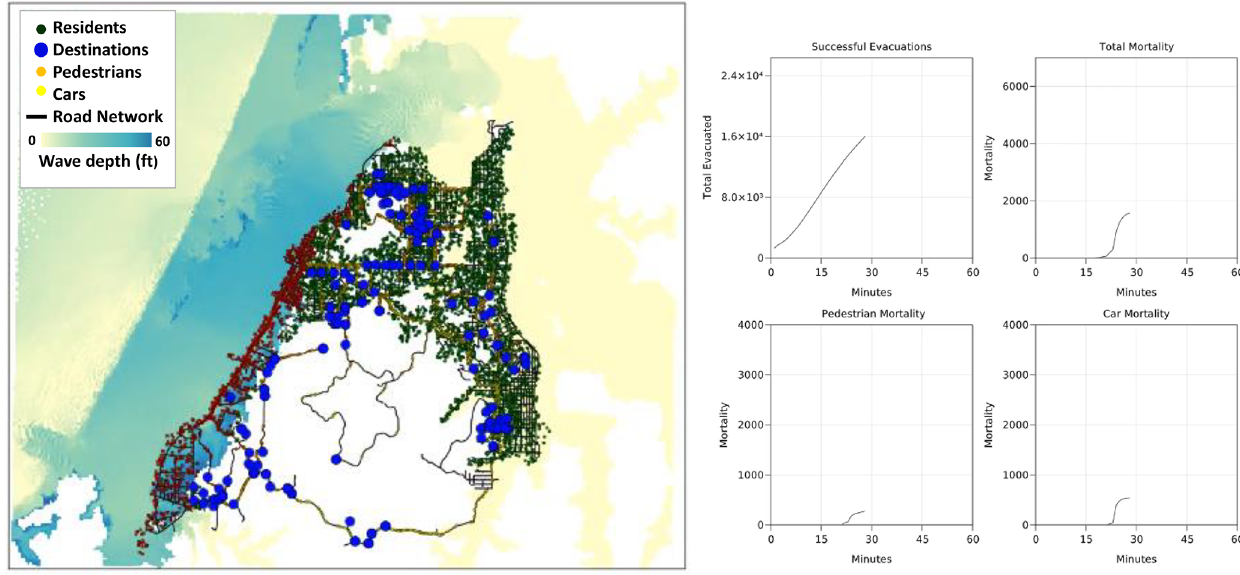
Figure 1. Simulation model visualization of Coos Bay, Oregon (1ft =